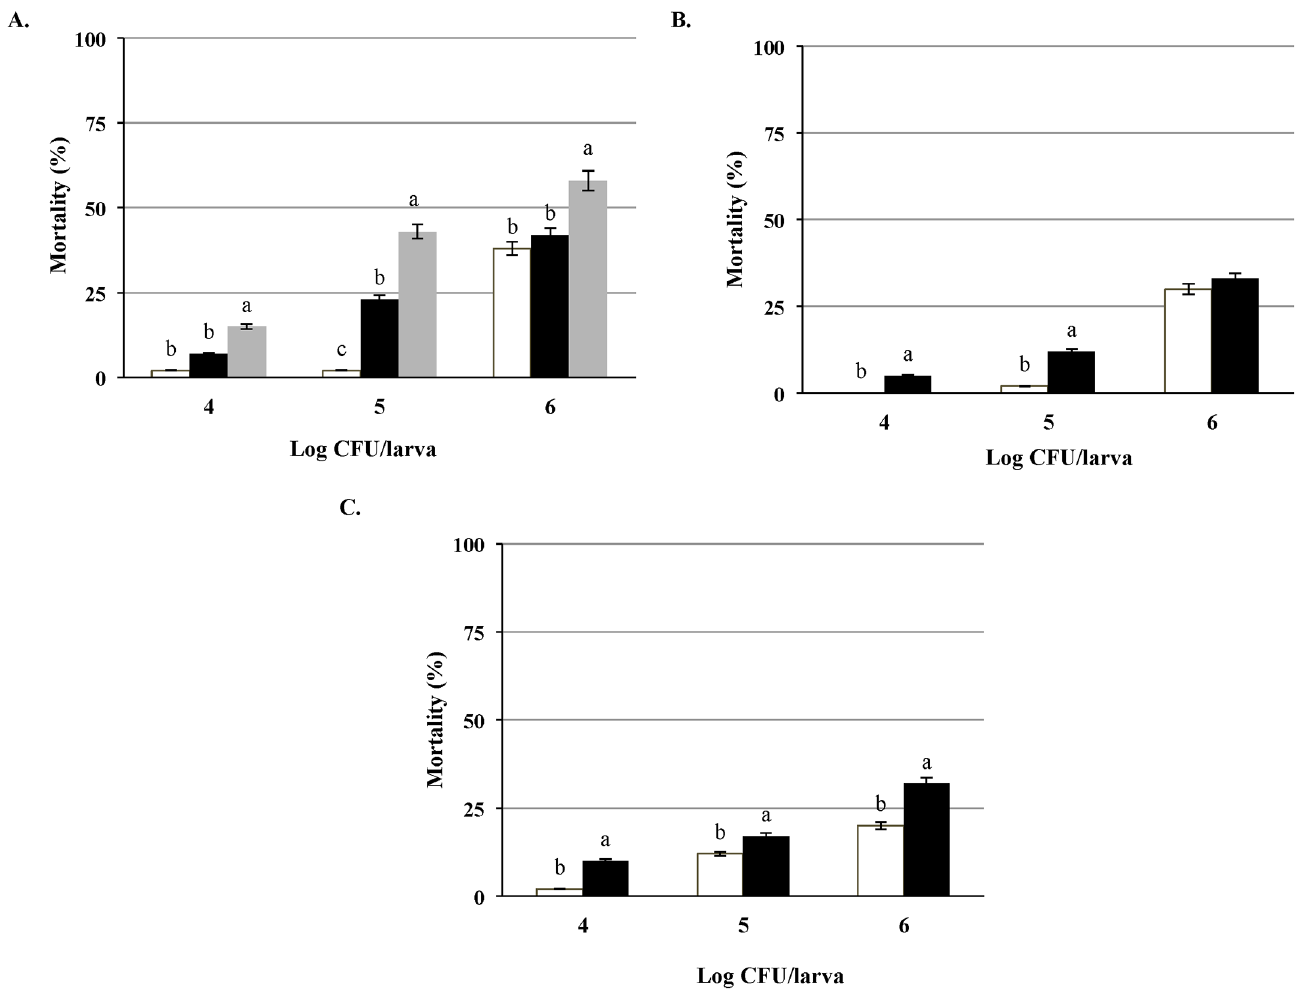
Fig 5. Assessment of the virulence of clinical and food isolates of L . monocytogenes . Paralleltesting of the clinical isolates of L . monocytogenes (A) LS660 (designated with gray square) and food pairs isolatedfrom chicken salad LS661 (designated with black square) and celery ( □ ), (B) LS414 (designated with black square) and food pair isolatedfrom coleslawLS413 (designatedwith white square), (C) LS412 (designated with black square)and food pair isolated from cheese LS411 (designatedwith white square) at the doses of 10 4 , 10 5 and 10 6 CFU/larva, a > b (P < 0.05).